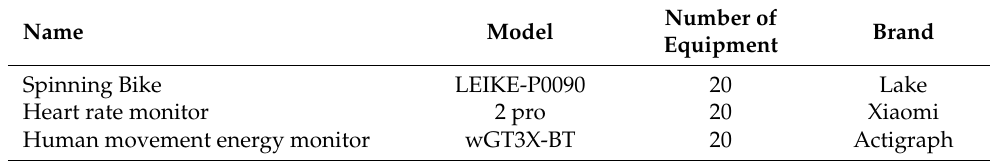
Table 1. Table teaching equipment